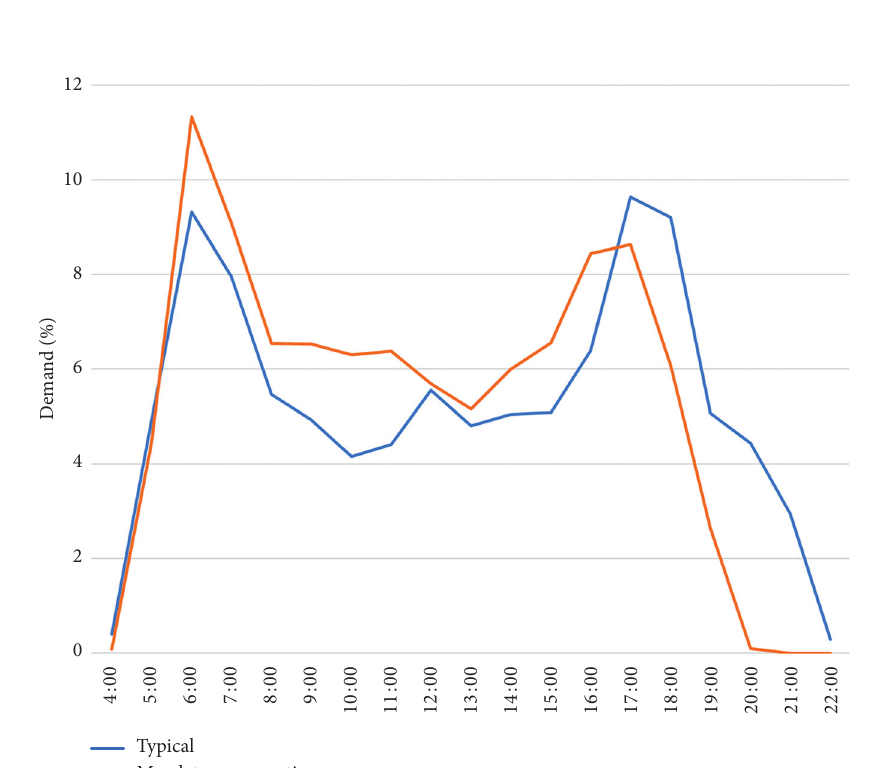
Figure 8: Hourly demand for Barranquilla’s BRT system during typical and mandatory quarantine